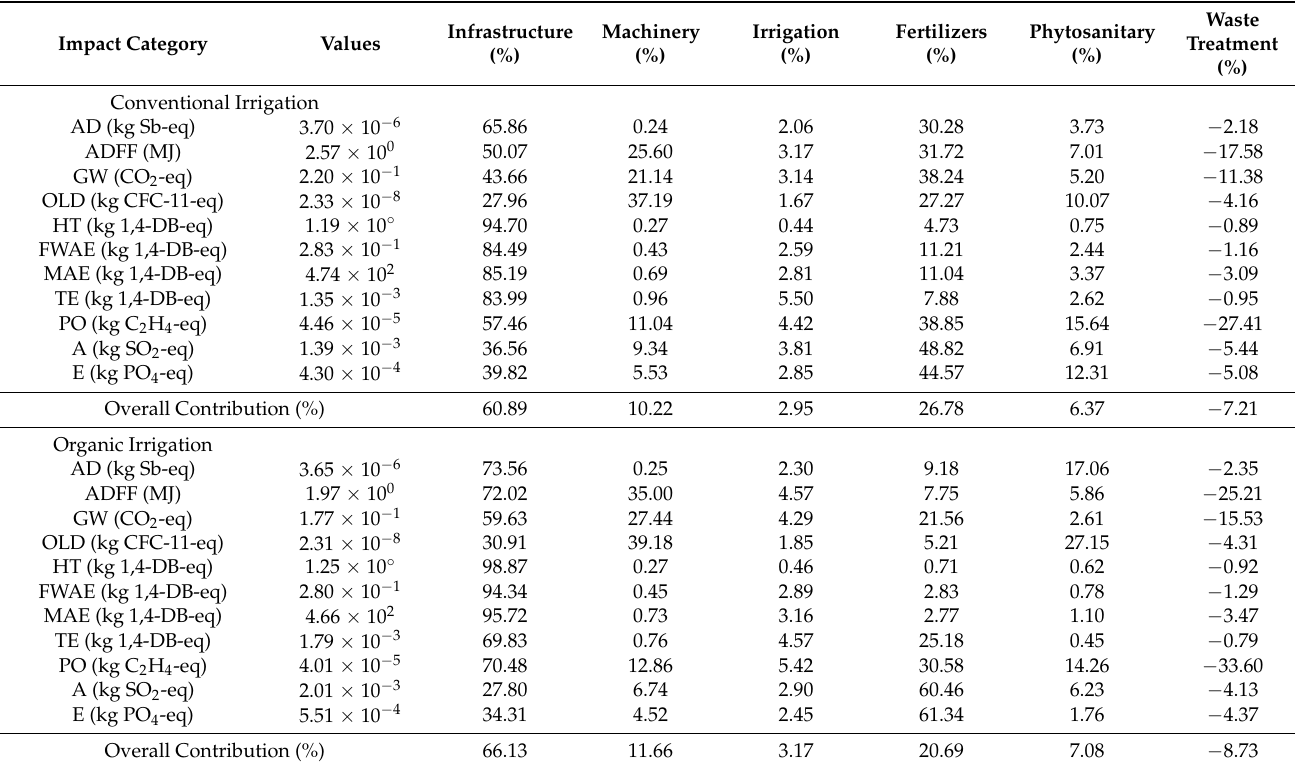
Table 9. Characterization of the potential environmental impacts and contributions of the components of the system in the conventional and organic irrigated